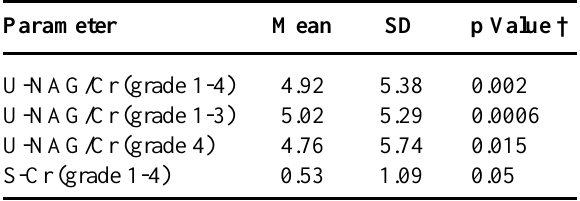
U-NAG/Cr (grade 1-4), data from patients with hydronephrosis grade 1-4 (n = 31); U-NAG/Cr (grade 1-3), pooled data from tients with hydronephrosis grade 1-4; † compared to reference